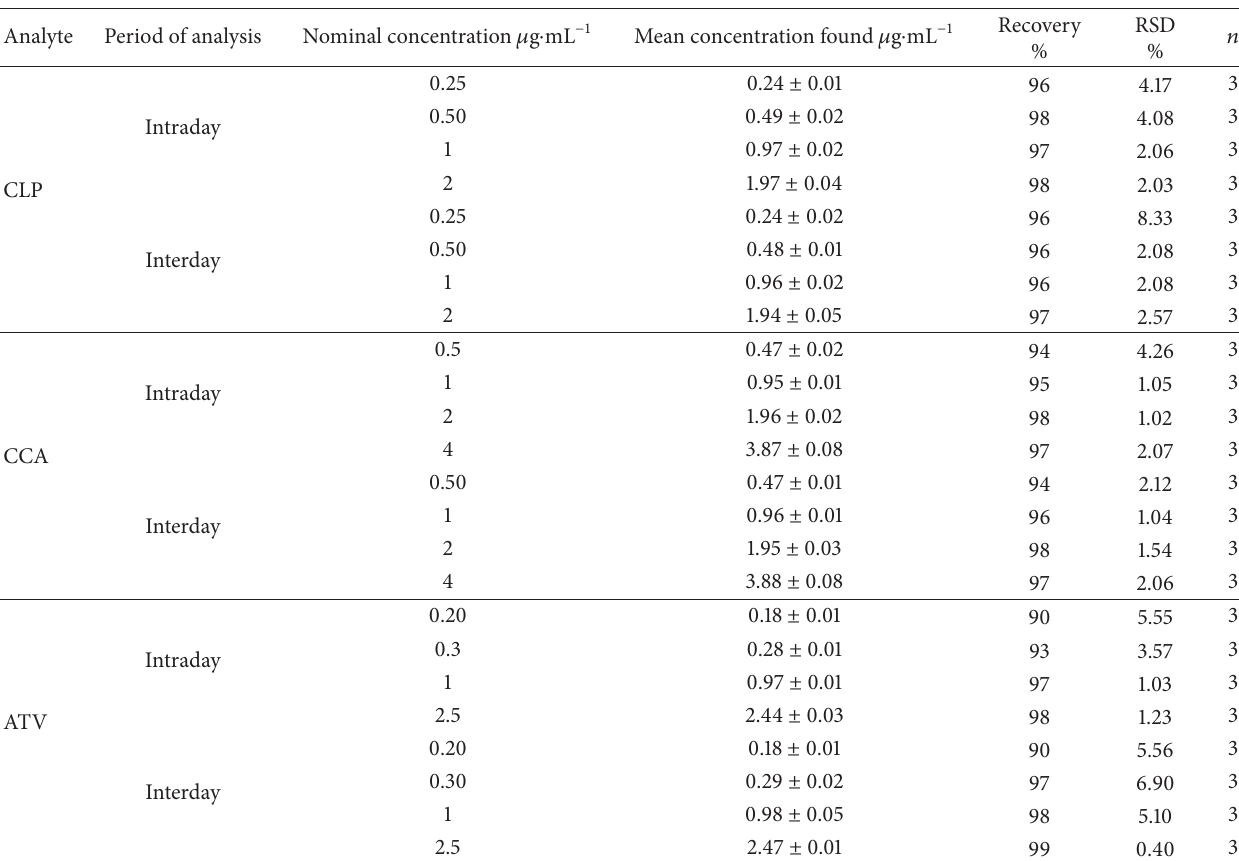
Table 2: Intraday and interday precision and accuracy of the method.